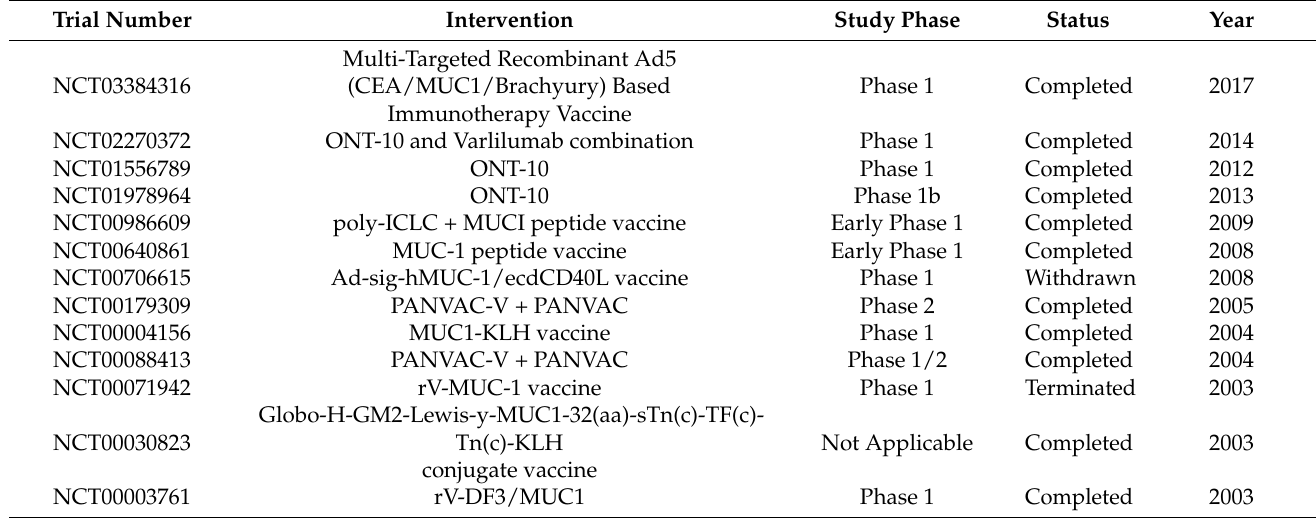
Table 2. MUC1-based cancer vaccine clinical trials (in